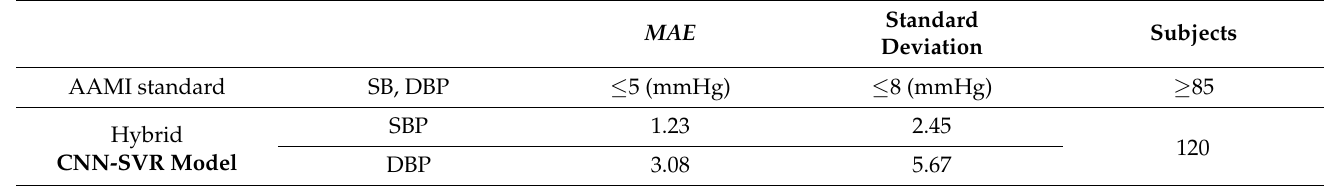
Table 1. Performance evaluation based on the AAMI standard.